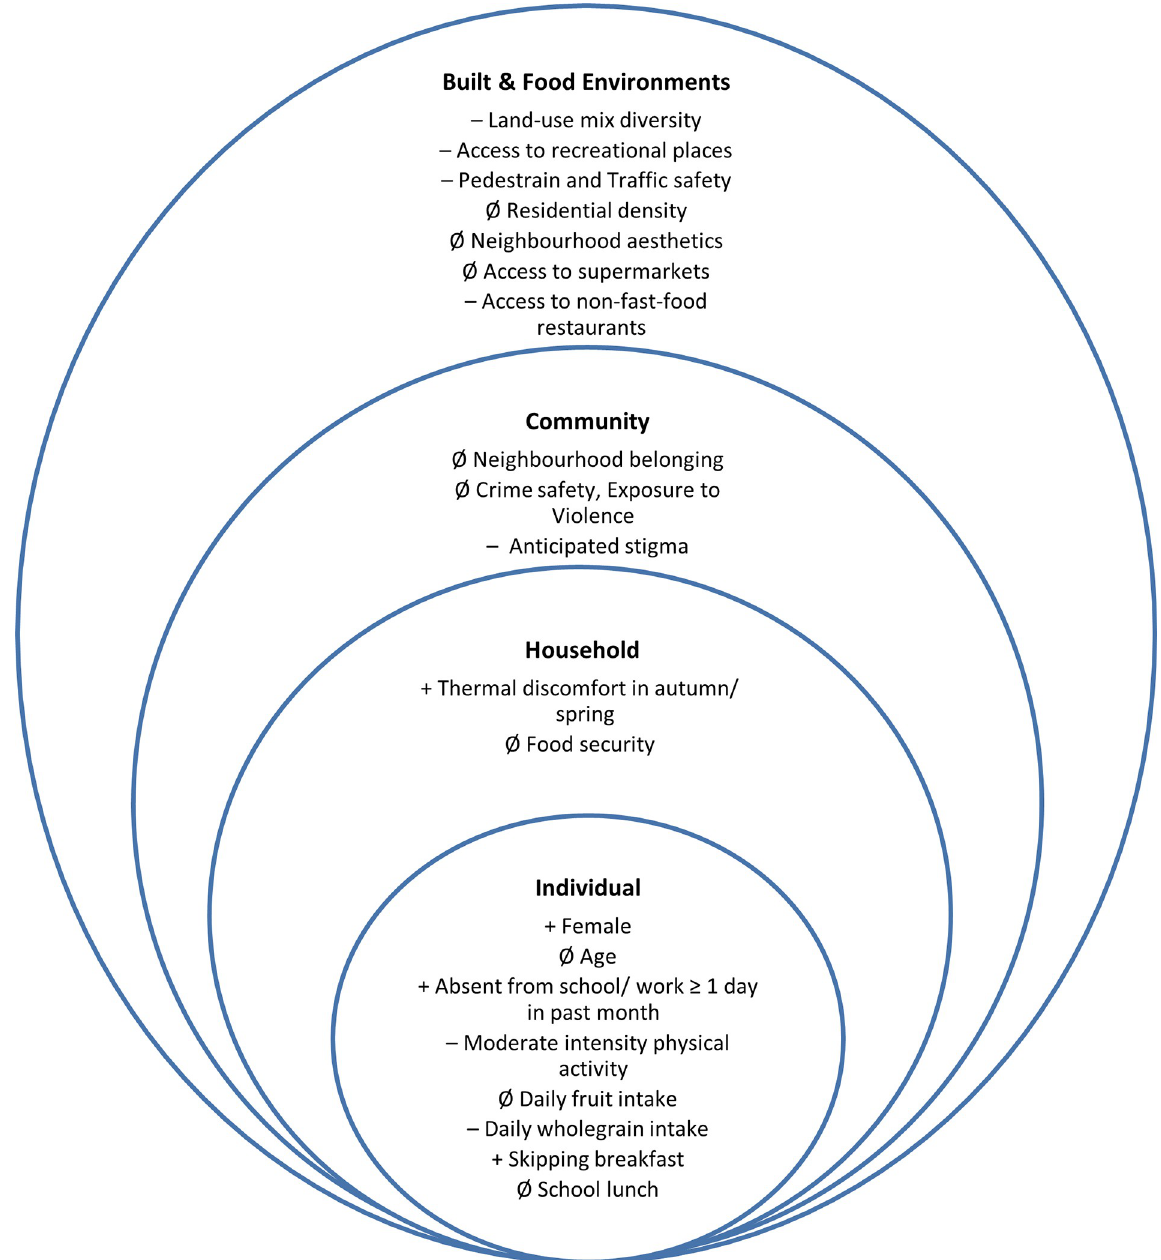
Fig 1. Multilevel factors associated with abdominal obesity. Covariates included in Fig 1 if statistically significant (p < 0.10) in bivariate regression. In multivariate regression: Ø no significant association; + significant positive association;–significant negative association.